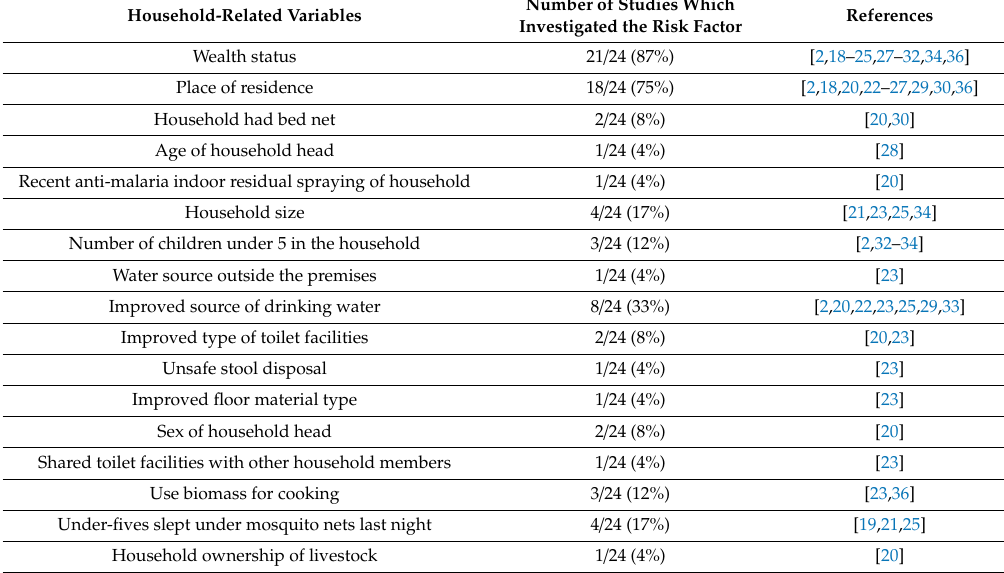
Table 7. Distribution of study characteristics by household-related